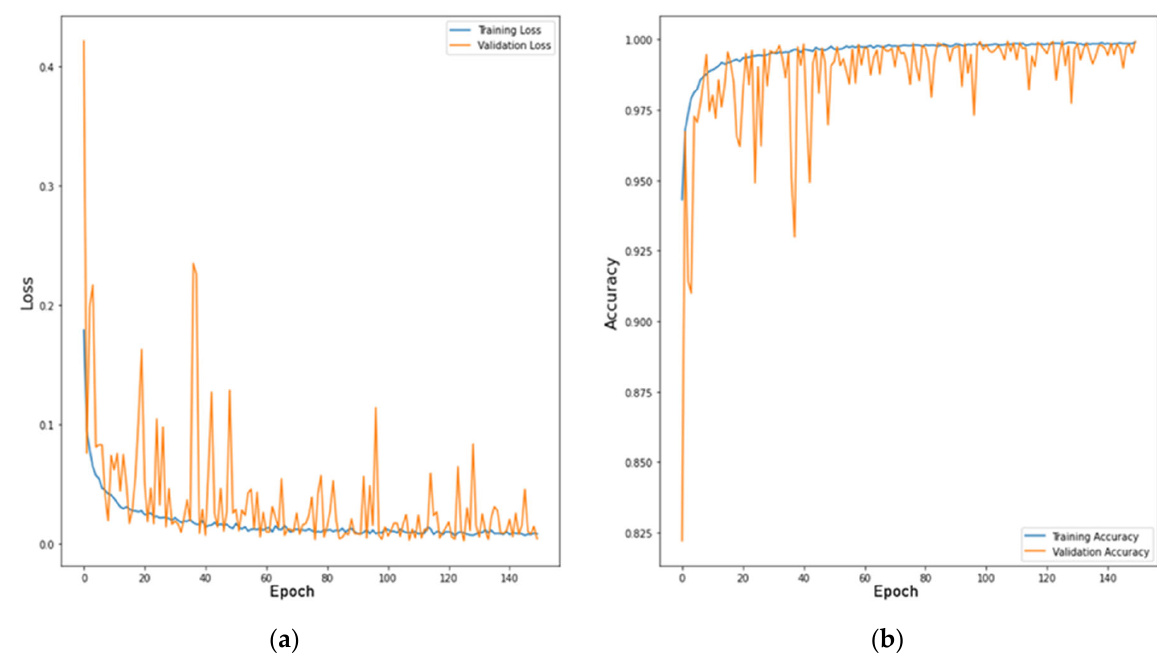
Figure 5. The hyperparameters are fine-tuned during the process of training the model. Table 1 represents the hyper parameter used in this proposed model.